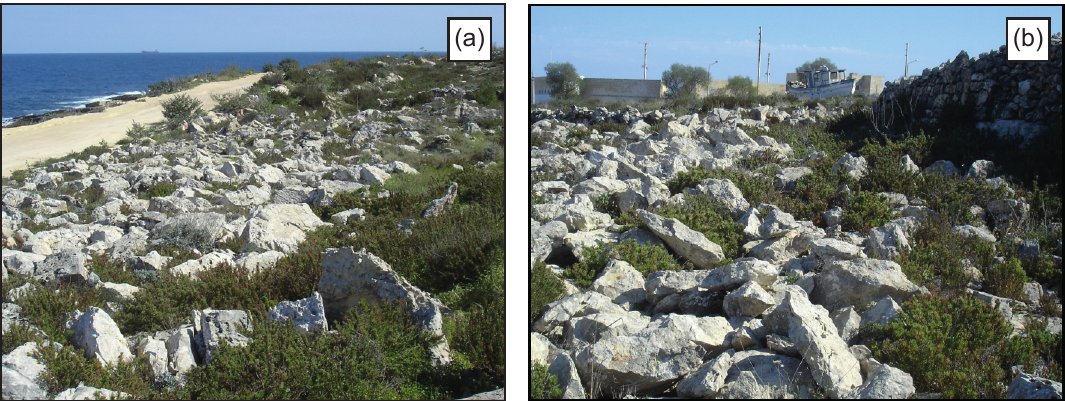
Figure 11. Boulder deposits at an elevation of 10–12 m asl, showing landward-facing imbrication and thus indicative of a seaward direction of the flow responsible for their imbricate organization: ( a ) north field; ( b ) south field. In both cases the shoreline is to the